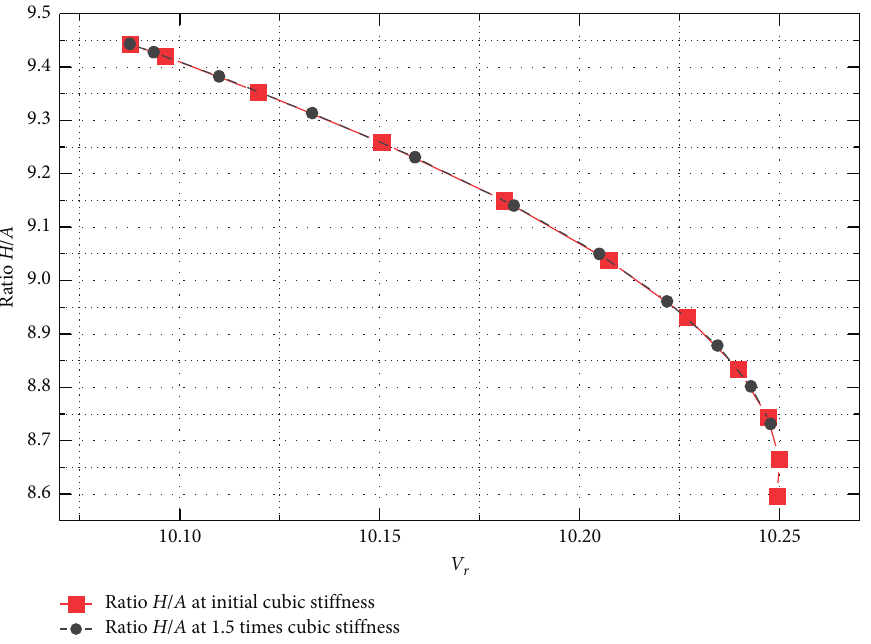
Figure 17: Curve of wind speed and frequency of LCOs.